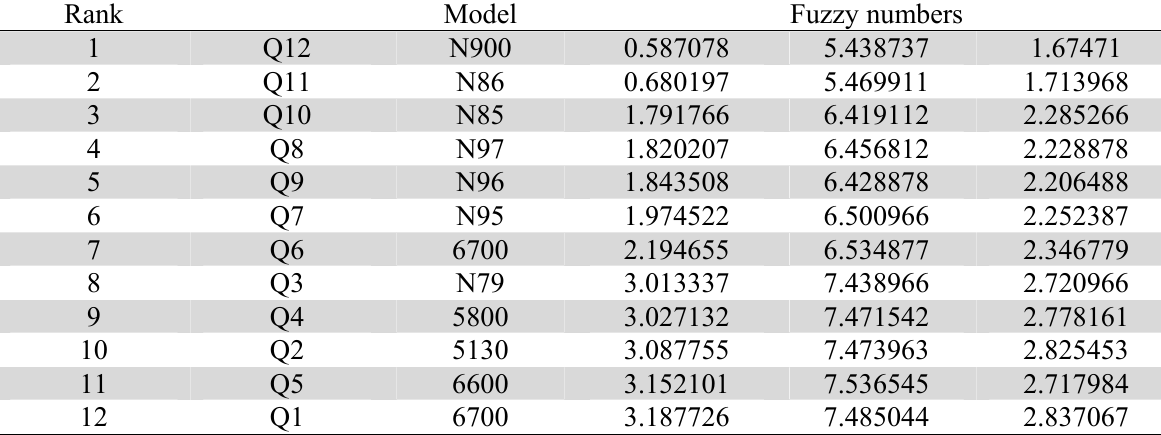
Final ranking of cell phone